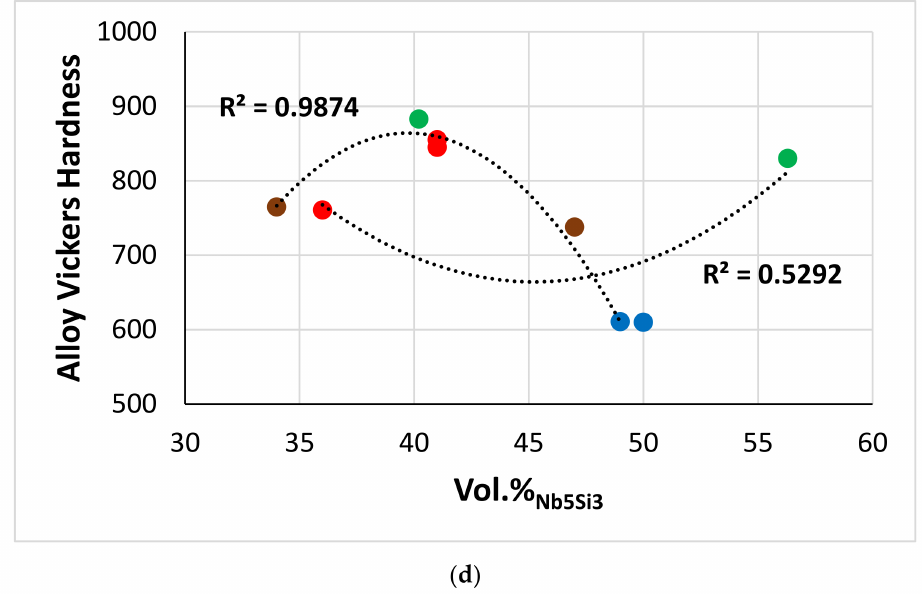
Figure 22. Alloy Vickers hardness versus vol.% ( a ) of Nb ss , ( c ) of A15-Nb 3 X, and ( d ) of Nb 5 Si 3 , and ( b ) vol.% Nb ss versus ∆ χ Nbss . In ( d ), R 2 = 0.5292 for the as-cast alloys and R 2 = 0.9874 for the heat-treated alloys. In ( b ), the R 2 value is for the alloys where the Nb ss is a stable phase. Colors as follows: blue alloy EZ2, red EZ5, brown EZ6, and green EZ8. In ( a , c ), the dotted line is given to “guide the